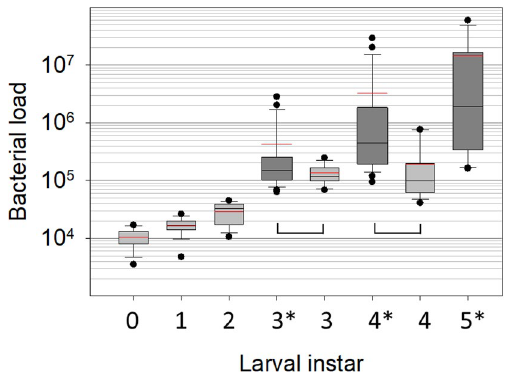
Figure 2. Bacterial load (log scale) of asymptomatic larval instars differs by apiary. Boxplots contain 25–75% of the data, whiskers are 10th and 90th percentiles, and dots represent the range. The red and black horizontal lines represent the mean and median respectively. Light grey box-plots represent larval instars 0–4 from an apiary in Arizona with no history or recent evidence of EFB disease (n = 15 for each larval instar, see Fig. 3). The dark grey box-plots* represent samples of asymptomatic larvae from asymptomatic colonies in apiaries in Illinois with active EFB disease (n = 23 or 24 for each larval instar). As indicated by brackets above the x-axis, asymptomatic larval instars differ in bacterial load according to t-tests of log-transformed normalized abundance (3rd instar; T36 = − 1.8 p < 0.07, 4th instar; T36 = − 3.9, p <